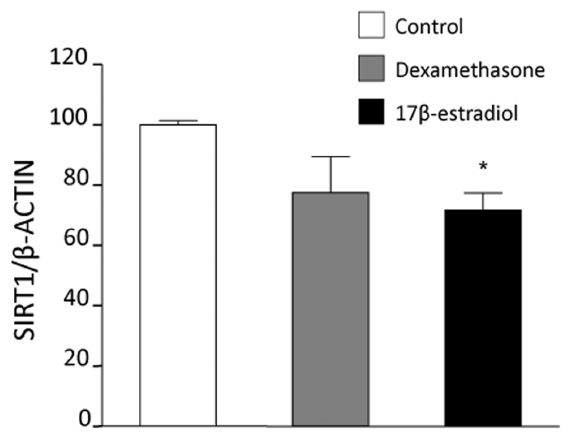
Figure 8. SIRT1 regulation by steroid hormone agents in freshly isolated human peripheral blood mononuclear cells (PBMCs). Cells were incubated with 10 nM dexamethasone or 10 nM 17ß-estradiol for 24 h. SIRT1 amounts in untreated PBMCs were taken as 100%. Values are mean 6 SEM (n=4). * p , 0.01 vs control.